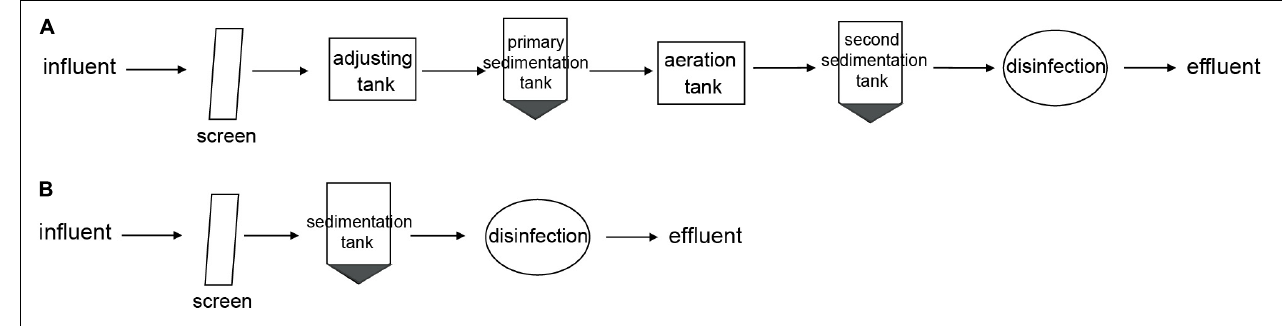
FIGURE 1 | Wastewater treatment process of two hospitals. (A) Activated sludge wastewater treatment process in eye hospital. (B) Direct chlorination disinfection wastewater treatment process in general